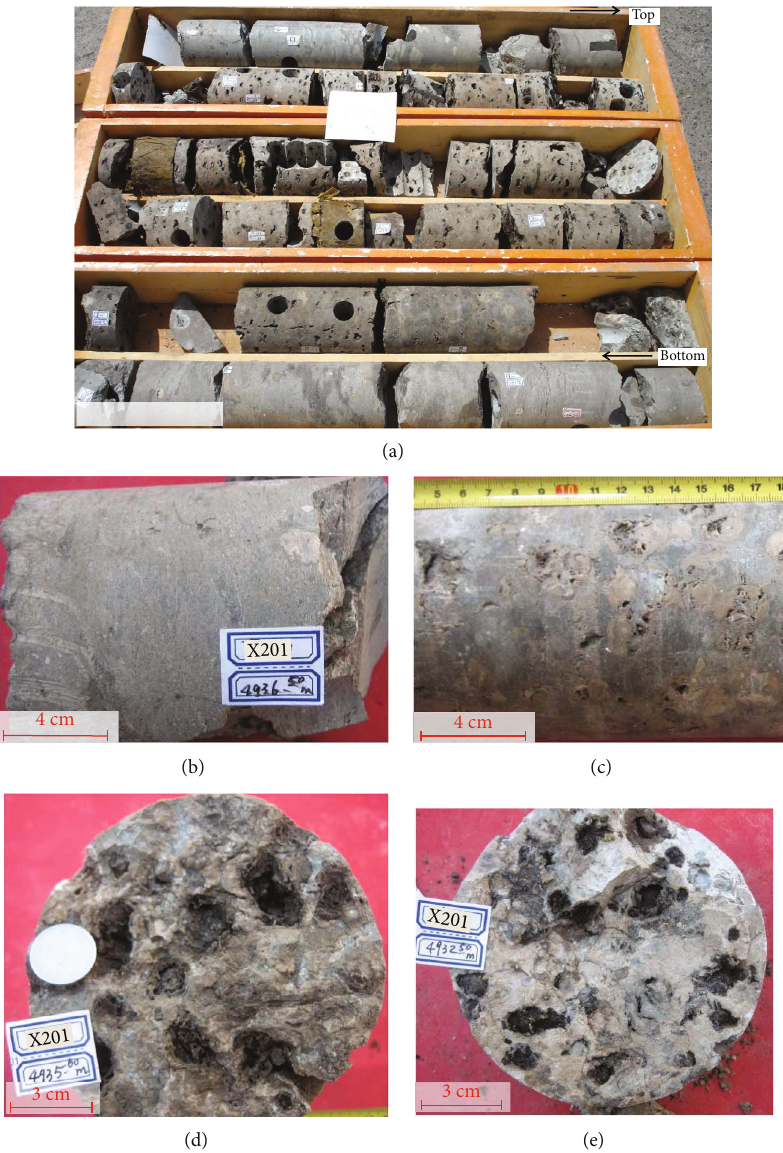
Figure 3: (a) Photo of core taken from the third coring of Well X201. (b) 4,936.5 m, weakly fused tu ff , with no development of vesicles. (c) 4,936m, fused tu ff , with the number of vesicles increasing upwards. (d) 4,935.6 m, strongly fused tu ff , with well-developed vesicles. (e) 4,932.5 m, fused tu ff , with the number of vesicles decreasing